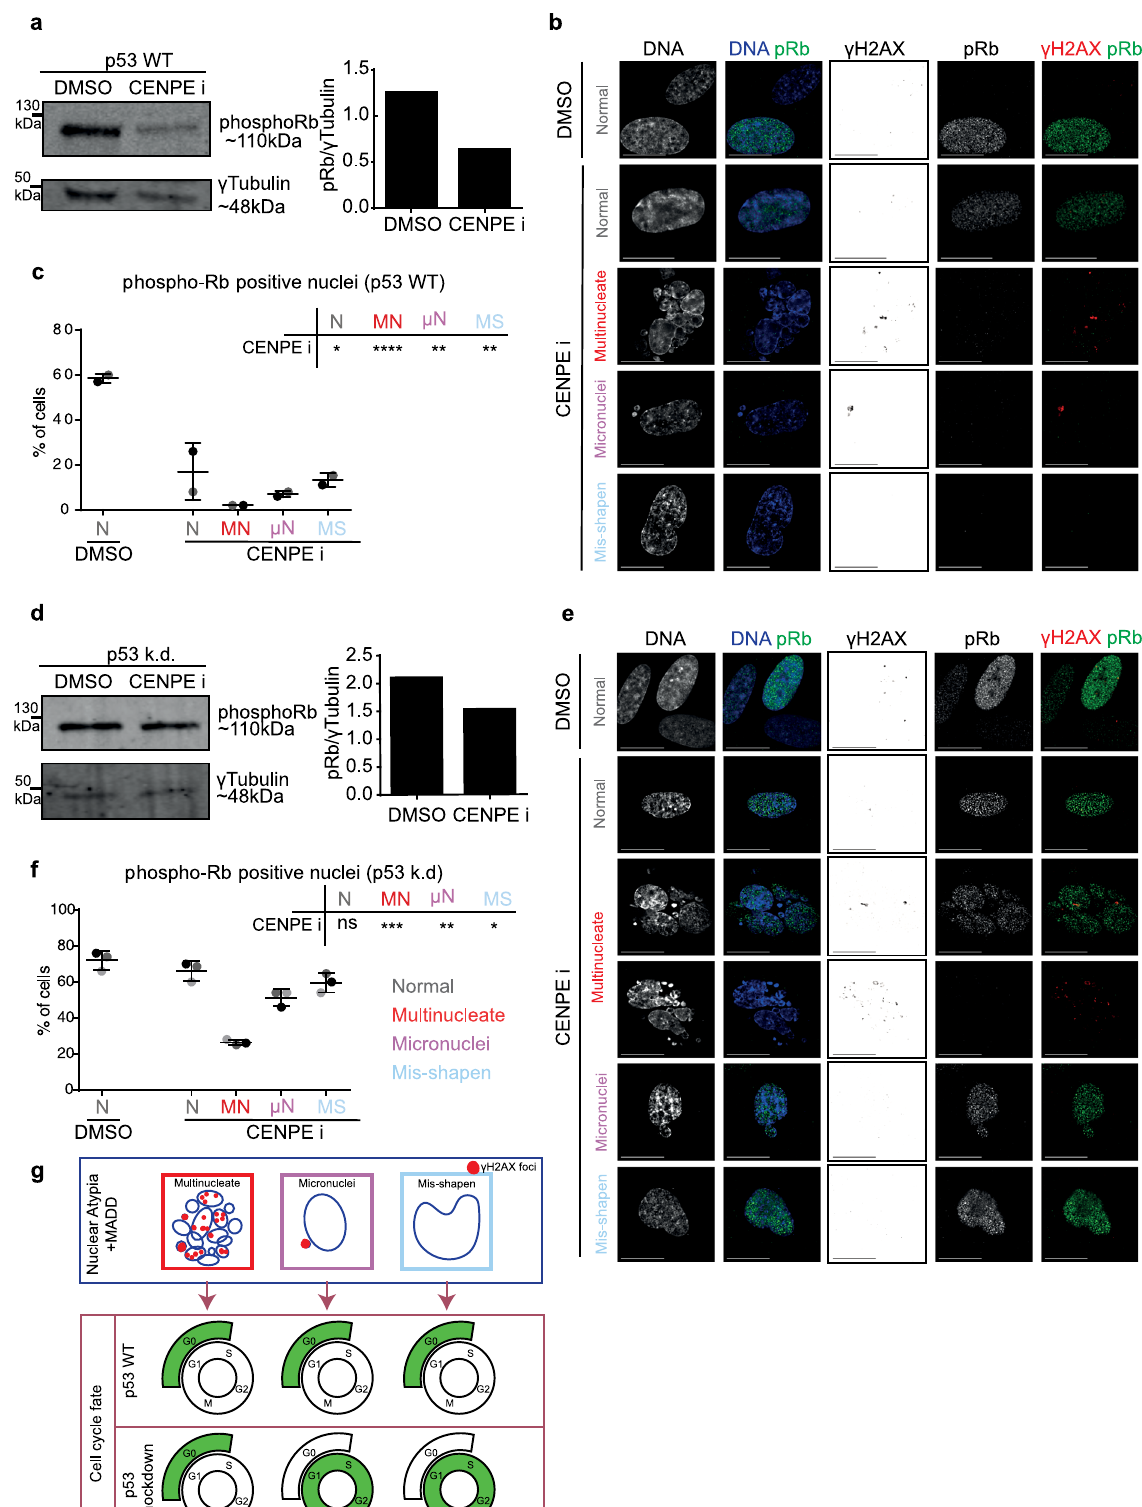
To image 53BP1-GFP foci arrival in cells following mitotic disruption RPE1 H2B-RFP 53BP1-GFP cells were treated with DMSO or GSK923295 for 24h. Cells were washed and then transferred to 37°C Leibovitz imaging media with DMSO or ZM447429 in the media. Cells were then imaged for at least 12h with an image taken at least every 30 min. Images were acquired using a 40 ×0.75NA objective on a DeltaVision Core TM microscope (GE Healthcare) with a Cascade2 camera under EM